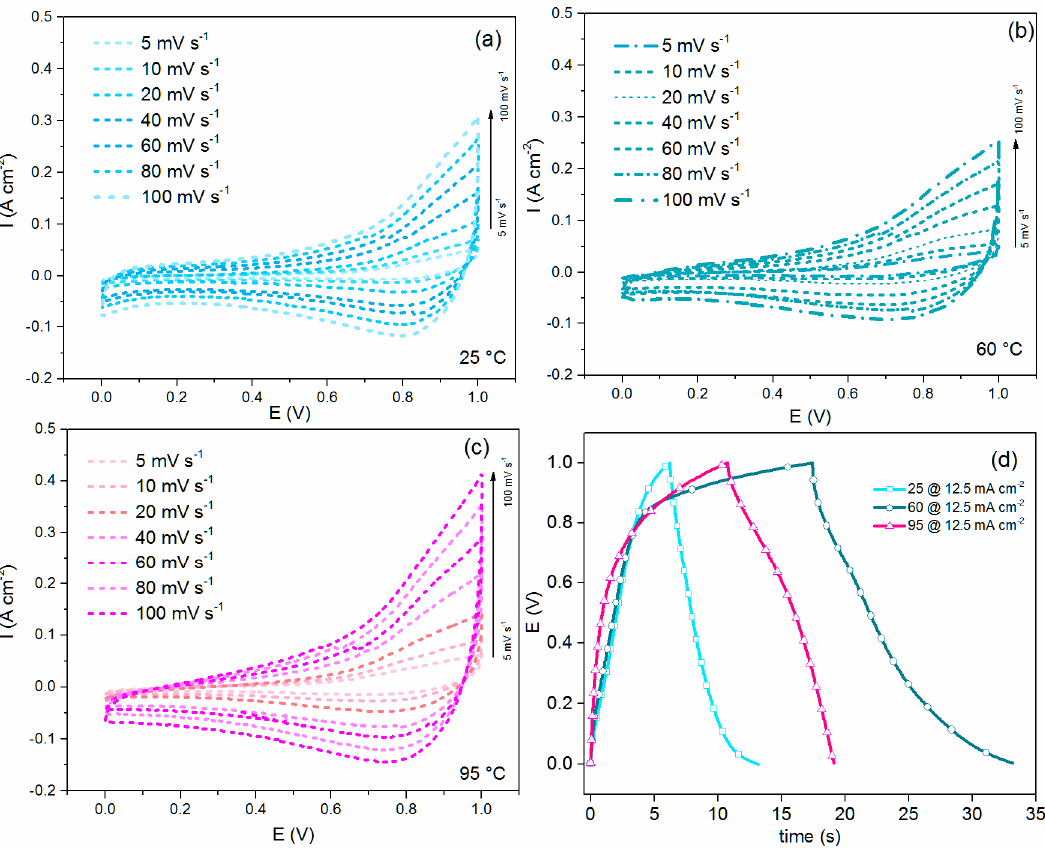
Figure 8. Voltammogram of the symmetric electrochemical cell (EC) as-deposited at ( a ) 25 °C, ( b ) 60 °C, ( c ) 95 °C, and ( d ) galvanostatic charge/discharge profiles of the different ECs at a current density of 12.5 mA cm − 2 .